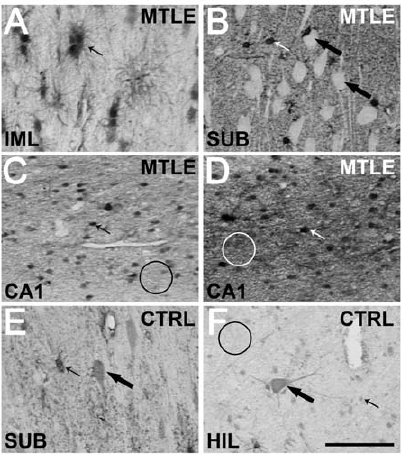
Figure 7. Representative images of MT-I/II staining in several hippocampal subfields. Almost all stained cells have astrocyte morphology (indicated by small arrows in A–F), while neurons remained unstained (white cells pointed by large arrows in B). Only in few cases from Ctrl (E and F) and in one region of one case of TLE were observed cells with neuron morphology (large arrows in E and F). No stained neuron presented the strong staining of astrocytes. In Ctrl, neuropil presented a weak staining (indicated by black circle in F). In TLE the neuropil staining level was heterogeneous, as can be seen in CA1 sections depicted in C and D (indicated by white circles). The representative images shown are from the fascia dentate (A), subiculum (B and E), CA1 (C and D) and hilus (F) of Ctrl (E and F) and TLE cases (A– D). Bar in F indicates 100 micrometers.